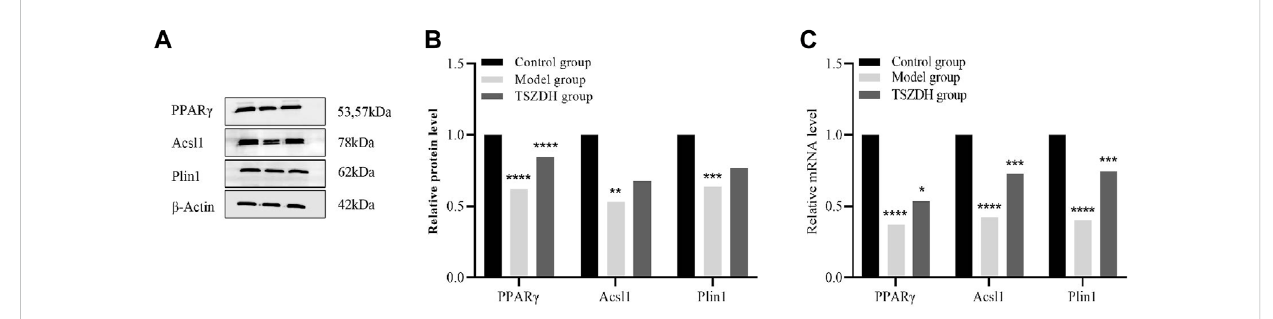
FIGURE 6 (A) The protein expression level of PPAR γ , Acsl1, and Plin1in the testicular cells. (B) The relative level of the proteins in the testicular cells. (C) The mRNA level of PPAR γ , Acsl1, and Plin1 in the testicular cells. * p < 0.05, ** p < 0.01, *** p < 0.001, **** p <